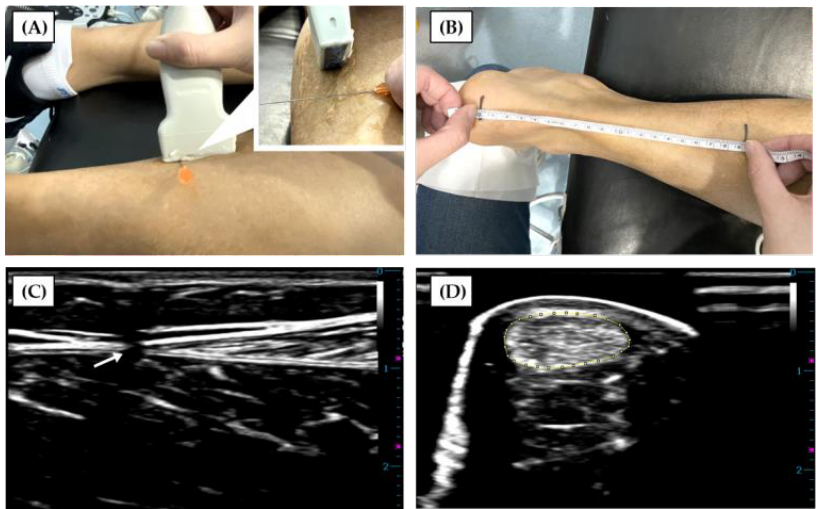
Figure 1. ( A ) The position (myotendinous junction (MTJ) of the medial gastrocnemius (MG) head and Achilles tendon (AT)) was marked on the skin where the ultrasound probe and needle crossed. ( B ) The distance between landmarks, defined as the length of the AT, was measured with tape. ( C ) The black shadow (indicated by a white arrow) in the ultrasound image was where the needle was placed, defined as the MTJ of the MG head and AT. ( D ) The cross-sectional area at the level of the medial malleolus was determined by manually tracing the border of the